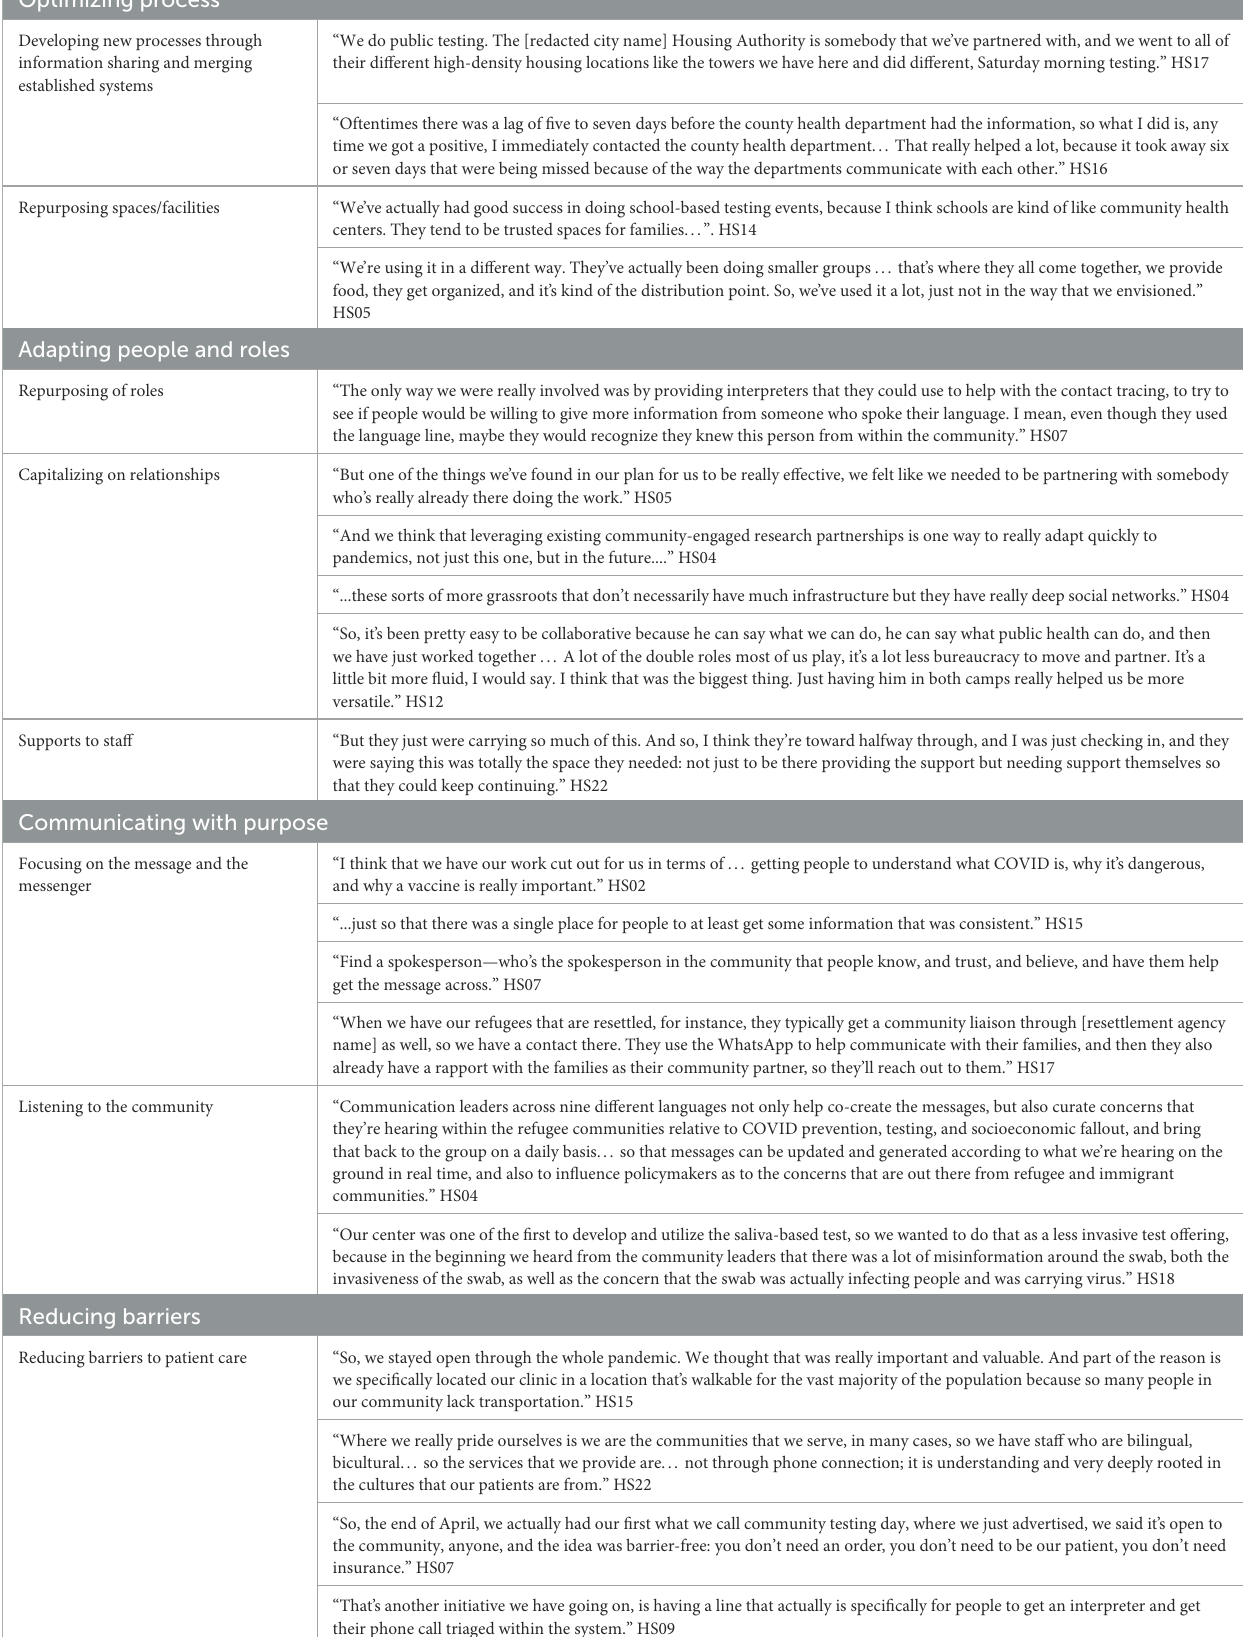
TABLE 4 Outward and inward facing